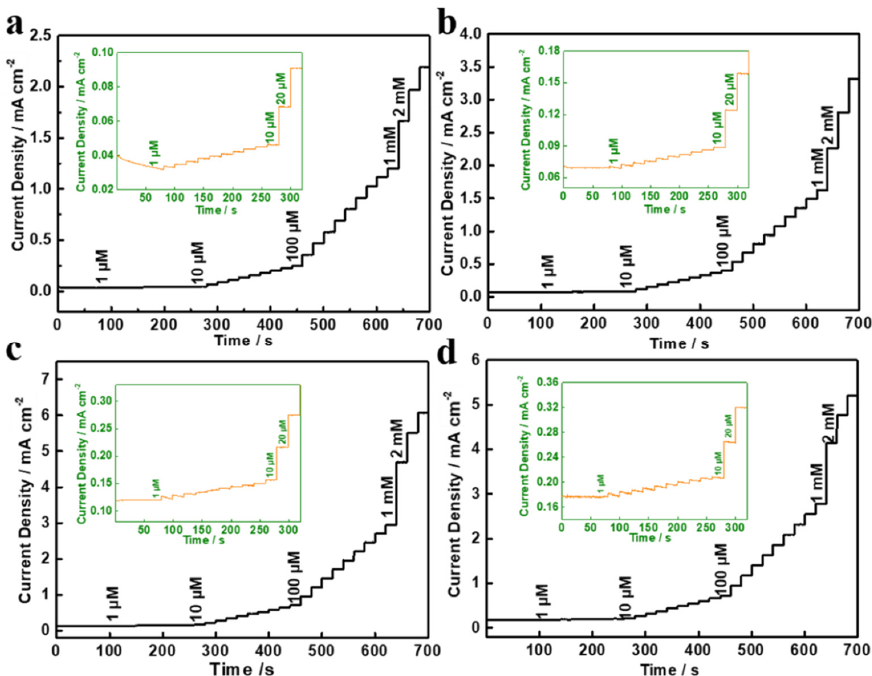
Figure 6. Typical amperometric response of different samples with the successive addition of glu- cose from 1 µ M to 2 mM in 0.1 M NaOH solution: ( a ) NiCo 2 O 4 -NC, ( b ) Ag/NiCo 2 O 4 -NC-30, ( c ) Ag/NiCo 2 O 4 -NC-60 and ( d ) Ag/NiCo 2 O 4 -NC-90. Inset: the amperometric response to glucose concentration of 1–20 µ M.